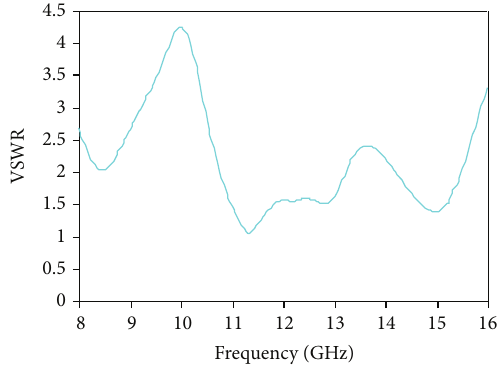
Figure 10: Gain of the proposed antenna. Figure 11: VSWR of the proposed antenna.